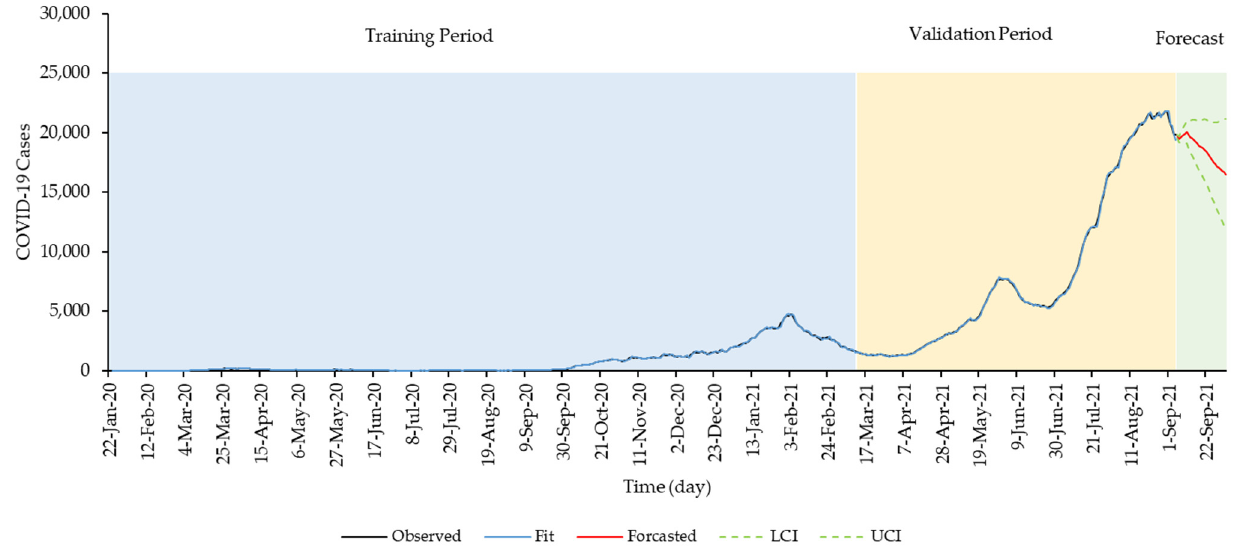
Figure 3. SARIMA (1,2,1) (2,0,0) model validation and forecast from 22 January 2020 to 3 October 2021, Malaysia (28-day forecast).